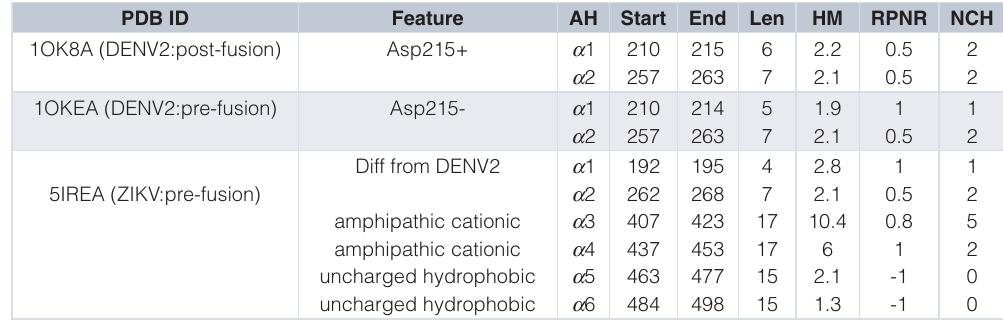
Table 2. Features of α -helices in envelope (E) proteins from DENV2 and ZIKV. The soluble ectodomain has two α -helices - α 1 and α 2. α 1 is perturbed in the post-fusion DENV2, increasing in length by one to include the known epitope Asp215. Moreover, α 1 is not conserved in the sequence space of ZIKV-E. α 2 remains conserved all E-proteins, even after fusion. α 3/ α 4 are amphipathic and cationic. The transmembrane helices ( α 5/ α 6) with no charged residues have a low hydrophobic moment. HM: Hydrophobic moment, RPNR: Relative proportion of positive residues among charged residues, Len: length of the α -helix, NCH: number of charged